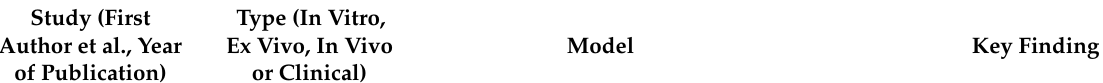
Table 3. Studies documenting MoA of 10 kHz